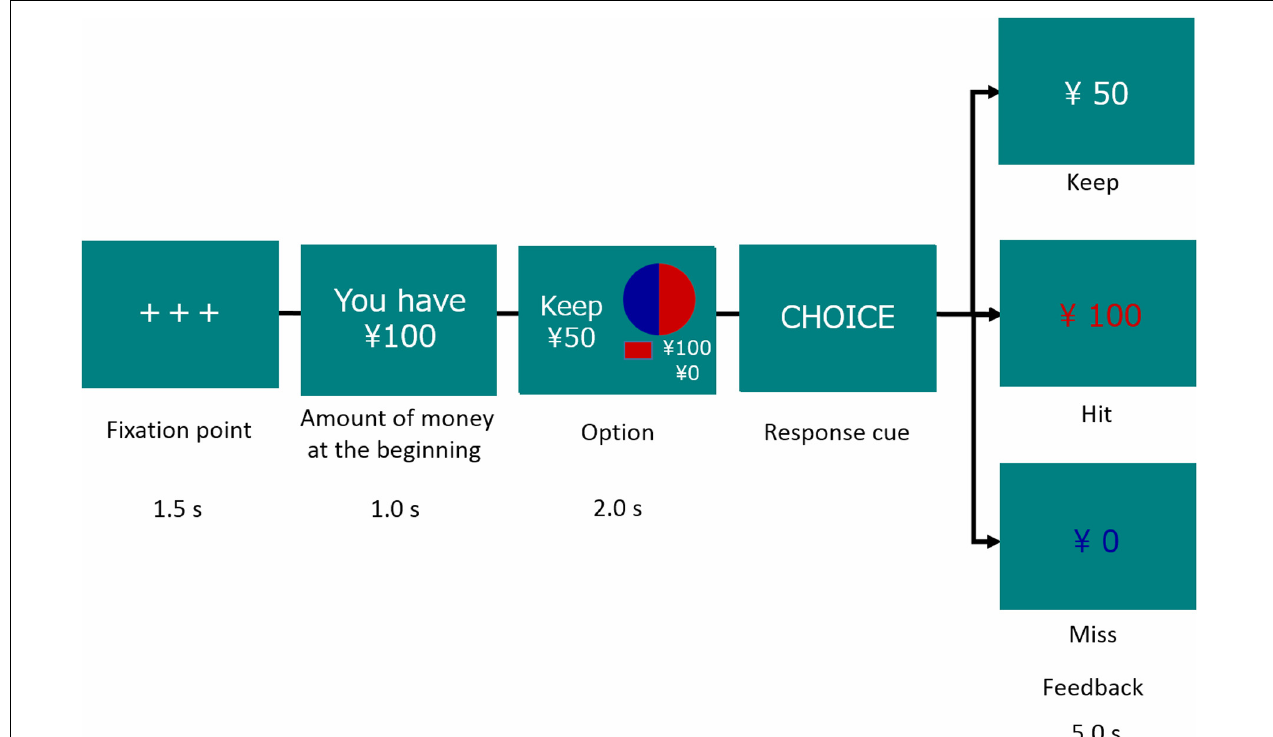
FIGURE 1 | Decision-making